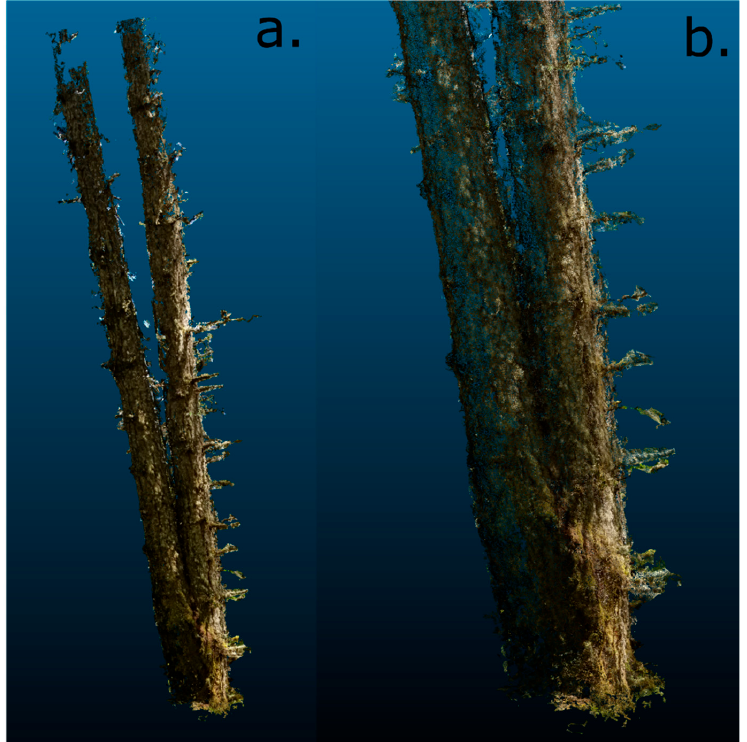
Figure 4. Sample photogrammetric point cloud for a tree in plot three developed with Structure from Motion: ( a ) whole tree extent and ( b ) detail.